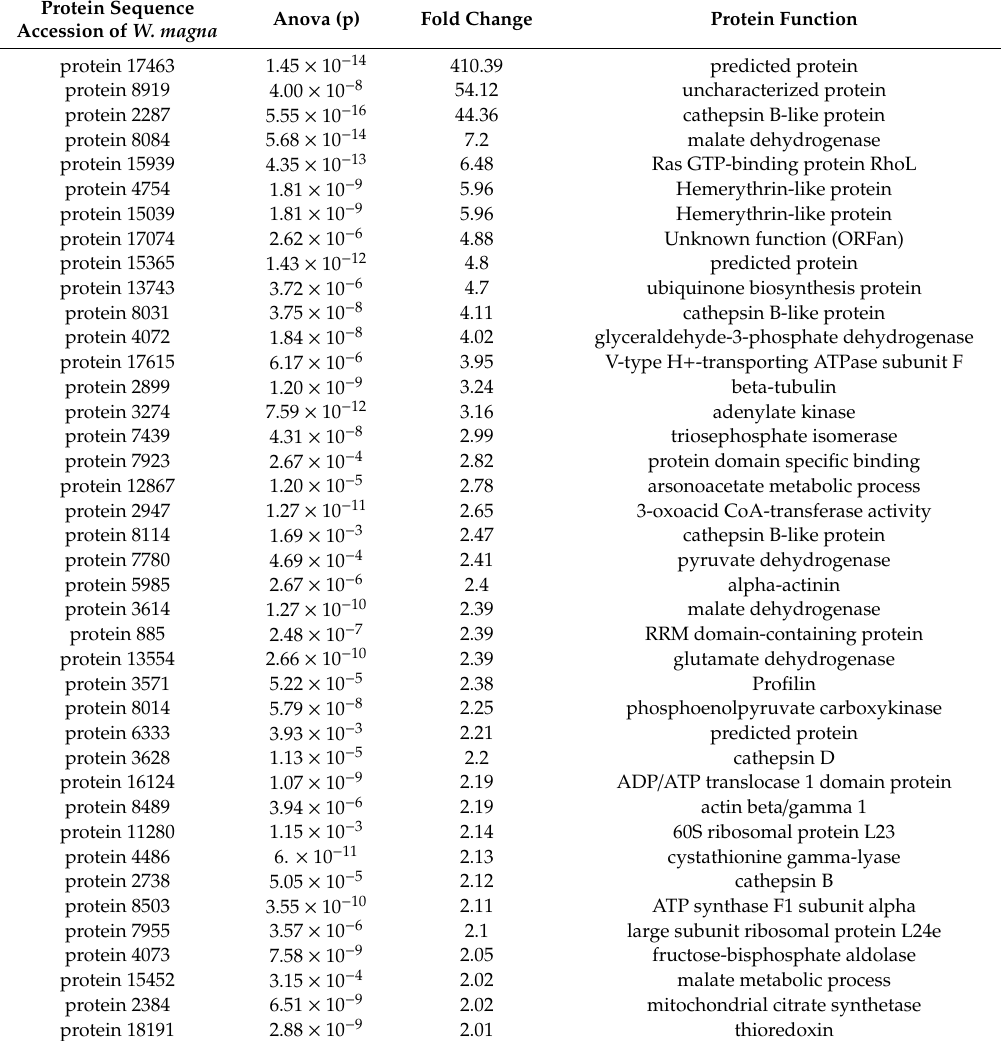
Table 1. Willaertia magna proteins up-regulated in adhesion and down-regulated in suspension culture. Protein Sequence Anova (p) Fold Change Protein Function Accession of W. magna protein